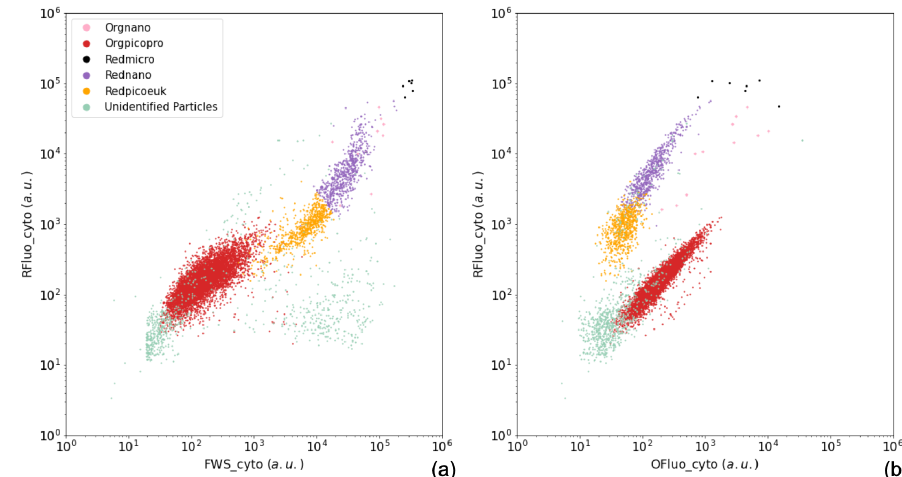
Figure A1. Manual identification of the main phytoplankton functional groups. Two-dimensional cytograms representing the following are shown: (a) the area under the curve of red fluorescence (RFluo_cyto, a.u.) versus forward scatter (FWS_cyto, a.u.) of each particle, depicting the main cytometric functional groups identified, namely Orgnano (pink dots), Orgpicopro (red dots), Redmicro (black dots), Rednano (purple dots), Redpicoeuk (orange dots), and the Unidentified particles group (green dots); (b) the area under the curve of red fluorescence (RFluo_cyto, a.u.) versus orange fluorescence (Ofluo_cyto, a.u.) of each particle, evidencing the same groups. The size of the Orgnano and Redmicro points located in the top right-hand part of the cytograms was increased in order for them to be visible, as these groups comprise very few cells in each sample.